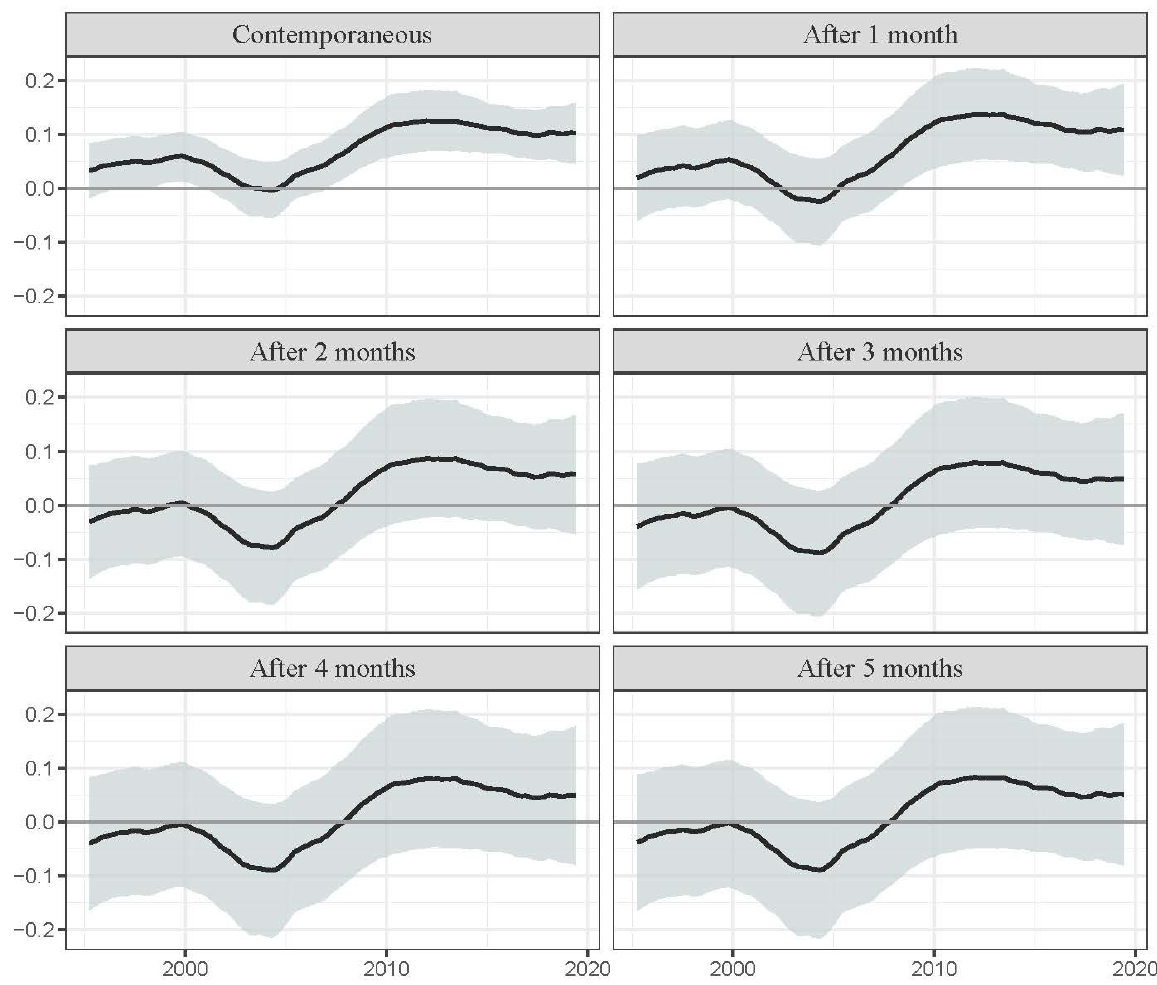
Figure A8. Responses of stock returns to an oil-specific demand shock. Note: This figure presents the accumulated responses of stock returns to a one-unit oil-specific demand shock in the first five months after the shock (1995:04–2019:06). The solid black line shows the mean while the gray area displays the 16th and 84th percentiles.